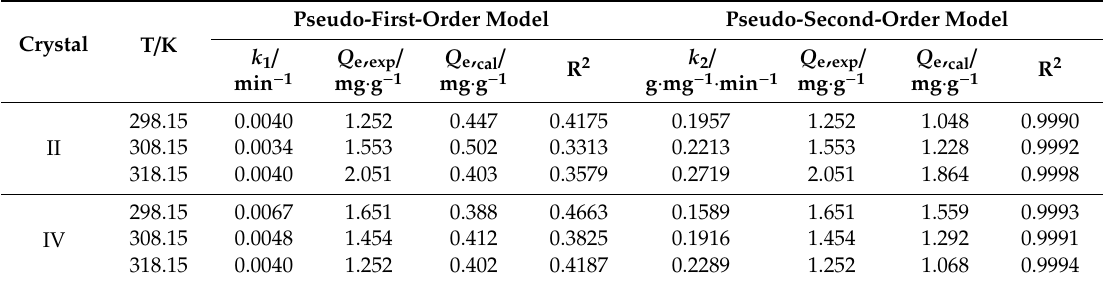
Table 7. Fitted values of kinetic equation for the adsorption of dispersant 2700 on the surfaces of di ff erent pyraclostrobin crystal particles at di ff erent